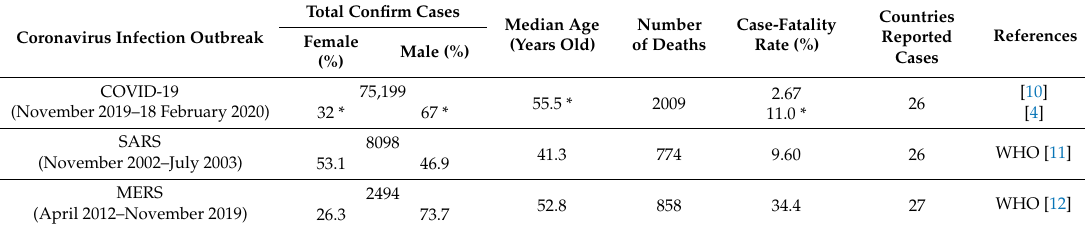
Table 1. The key information about the coronavirus infection outbreaks. Total Confirm Coronavirus Infection Outbreak